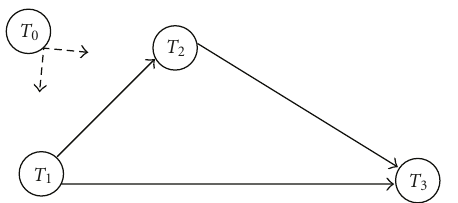
Figure 2: Example relay channel with asymmetric cognition capabilities. Only the source T 1 knows the interference from the competing source T 0 . The source helps the relay T 2 to cancel the e ff ect of the